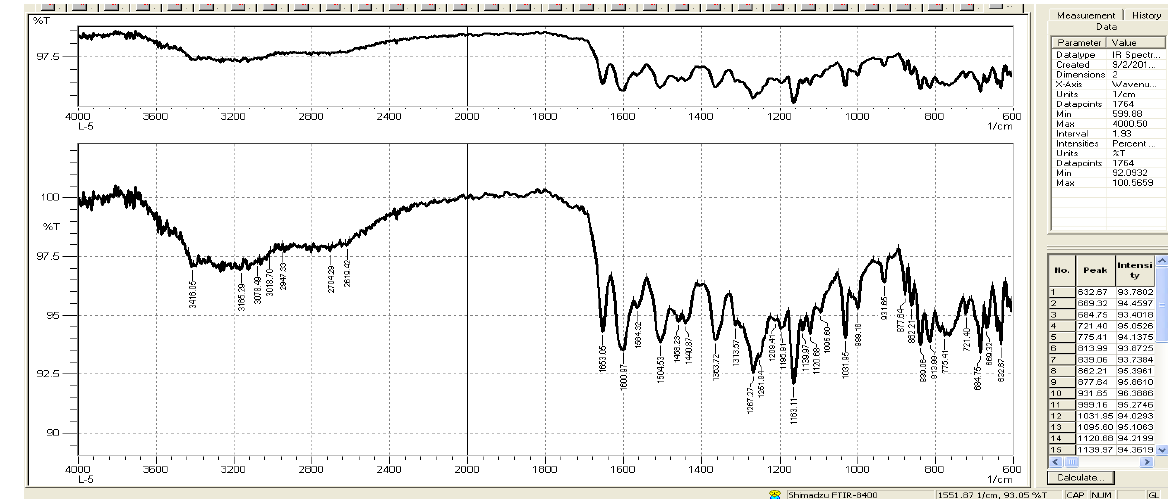
Figure14. FTIR spectrum of isolated luteolin. FTIR spectral analysis of isolated resorcinol compound show peaks at3400-3000, 2880,